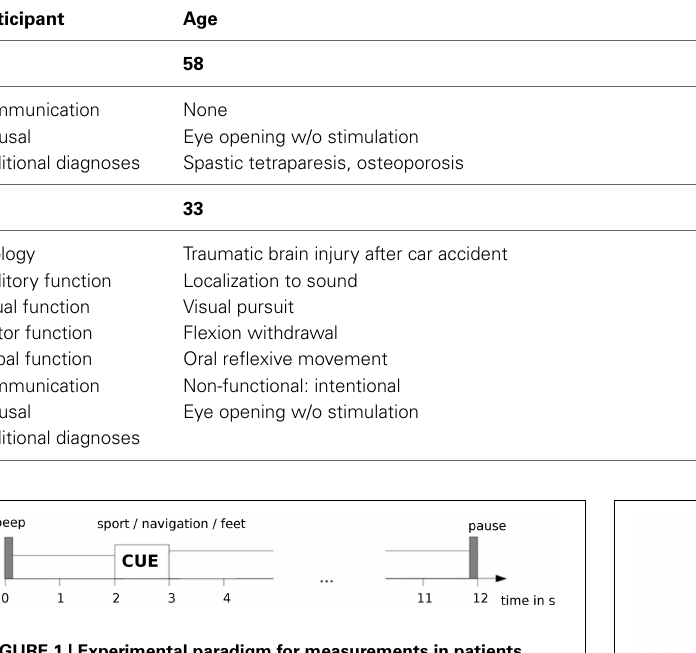
FIGURE 1 | Experimental paradigm for measurements in patients. Timeline of a single trial is shown here.